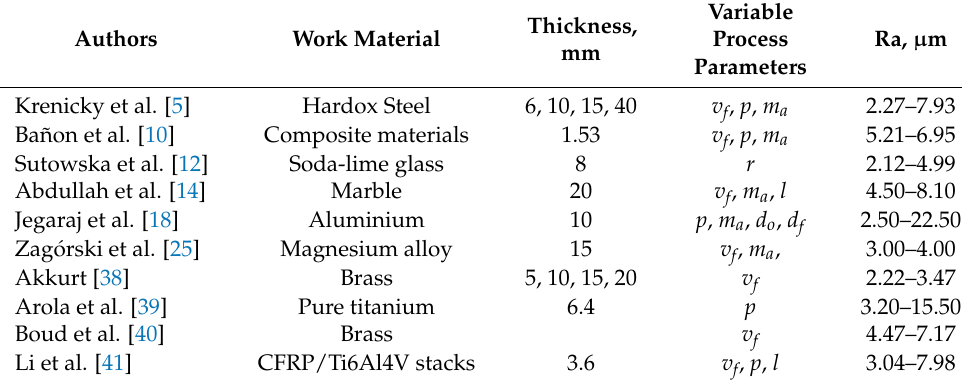
Table 1. Surface roughness studies on